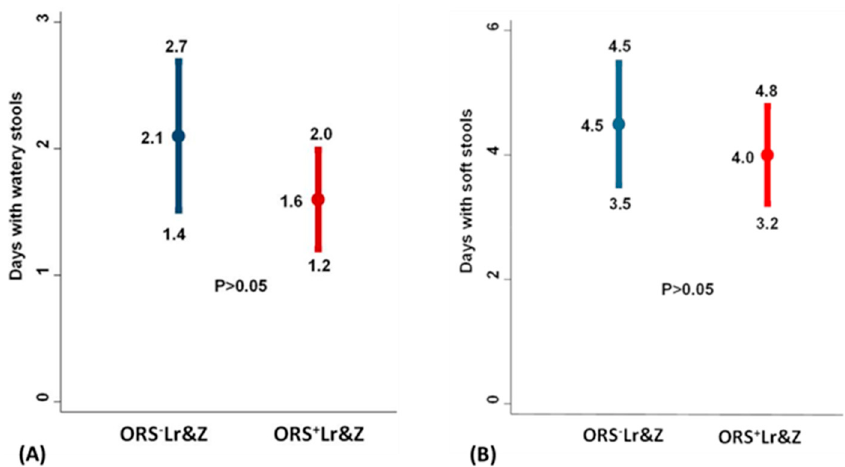
Figure 4. ( A ): Number of days with watery stools. ( B ): Number of days with soft stools. Results are presented with means and 95% confidence intervals. Comparisons between the ORS + Lr&Z and the ORS - Lr&Z arms were performed by the Mann-Whitney U test ( p > 0.5). The same was true for the number of days lost from the day care for the infants and from work for the parents, which tended to be less in the group which received ORS supplemented with L. reuteri DSM 17938 and zinc, but again, the differences did not reach statistical significance (Figure 5A,B).